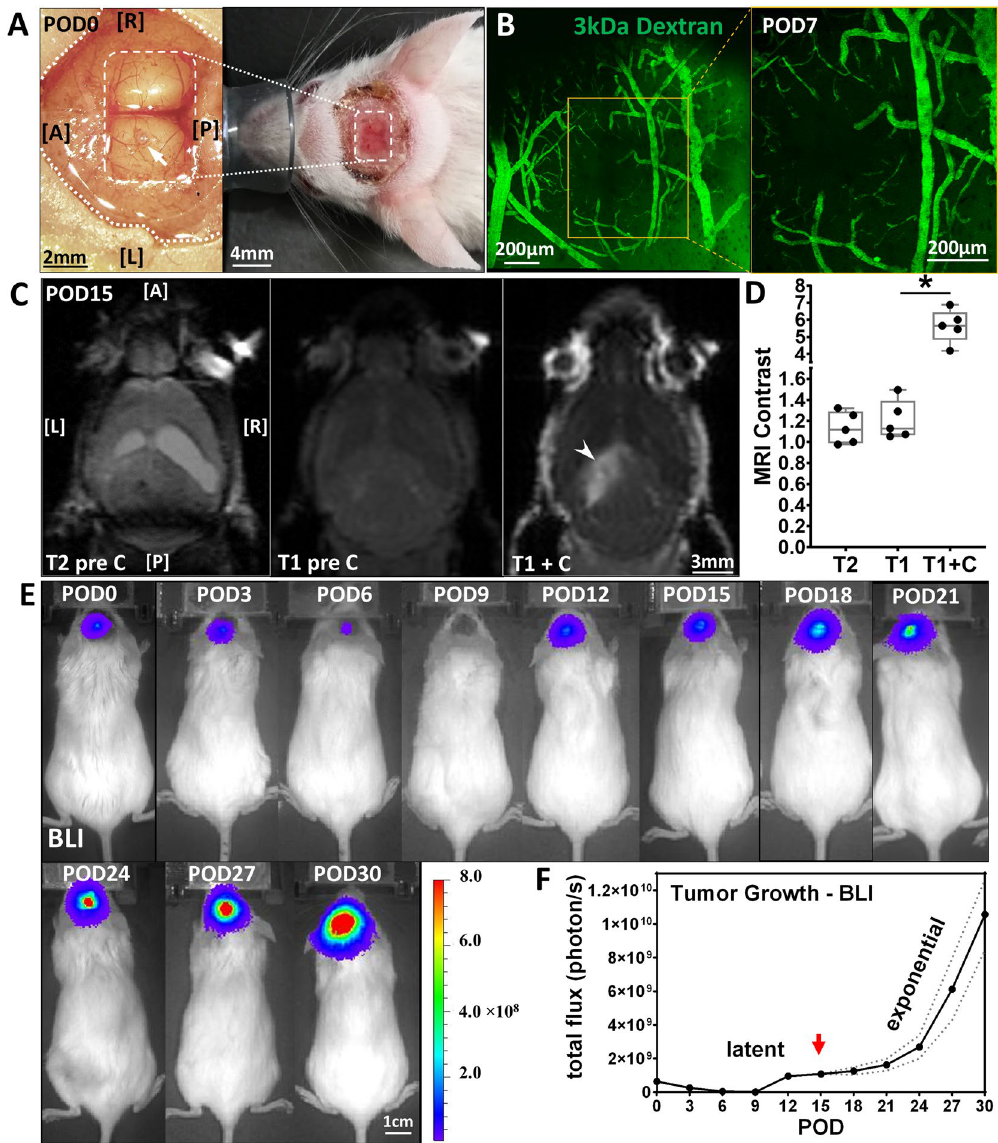
Figure 2. U251 orthotopic implant produces contrast enhancing HGG xenograft intracranial tumor in mice. ( A ) Photograph of U251 implanted ( arrow ) in mouse brain before ( Left ) and after ( Right ) cranial window ( dashed box ) placement in surgical field ( dotted lines ) on POD0. A: anterior; P: posterior; L: left; R: right. ( B ) Maximum intensity projection (MIP) image (2 × 2 stitched tiles) across 0-300 µm below cranial window 30 s after intravenous injection of 3 kDa fluorescein-dextran on POD7. Yellow box : a single-tile MIP image at implant site. ( C ) T2-weighted (pre-contrast) and T1-weighted (pre- and post-contrast) MRI scans from a mouse with U251 glioma xenograft on POD15. Arrowhead : non-enhancing region within tumor. ( D ) MRI contrast of tumor against normal (Mean ± SEM) revealed significant statistical difference (* P < 0.001) between T1-weighted images with and without contrast injection. ( E ) Bioluminescence imaging (BLI) of glioma xenograft growth in mice over 30 days. ( F ) Tumor size measured by bioluminescence grew exponentially after a latent period. Dotted lines : standard error of the mean. Arrow : beginning of exponential